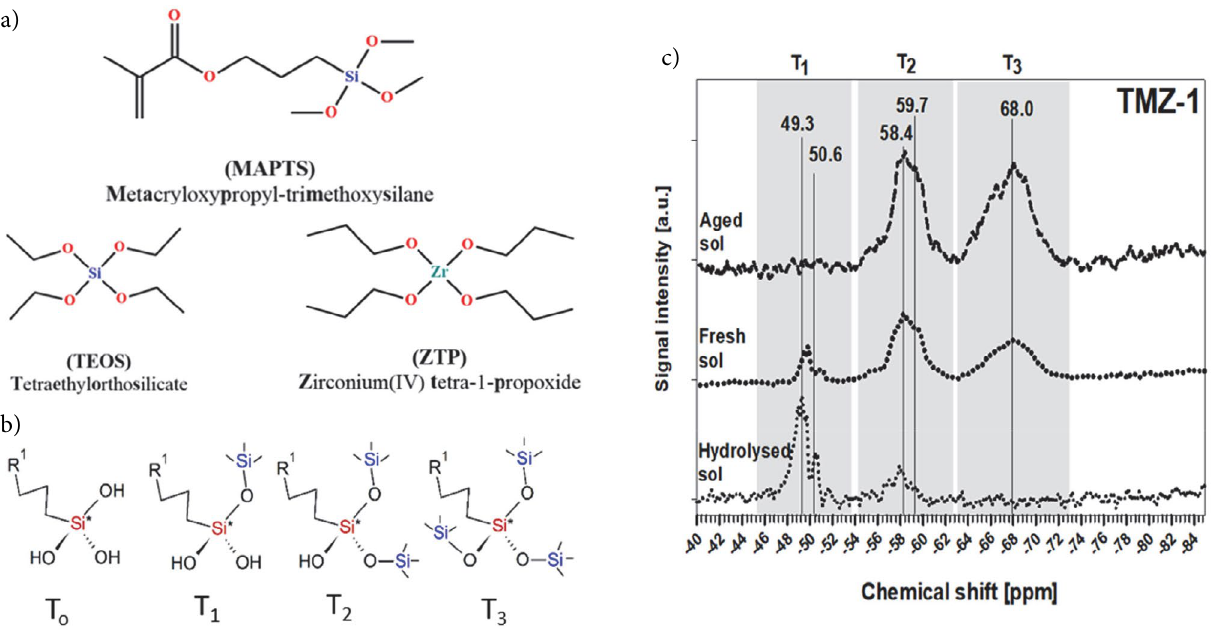
Figure 13. (a) Skeletal formulae of MAPTMS, TEOS and ZTP precursors for TZM coatings. (b) Different siloxane species with: three silanol groups